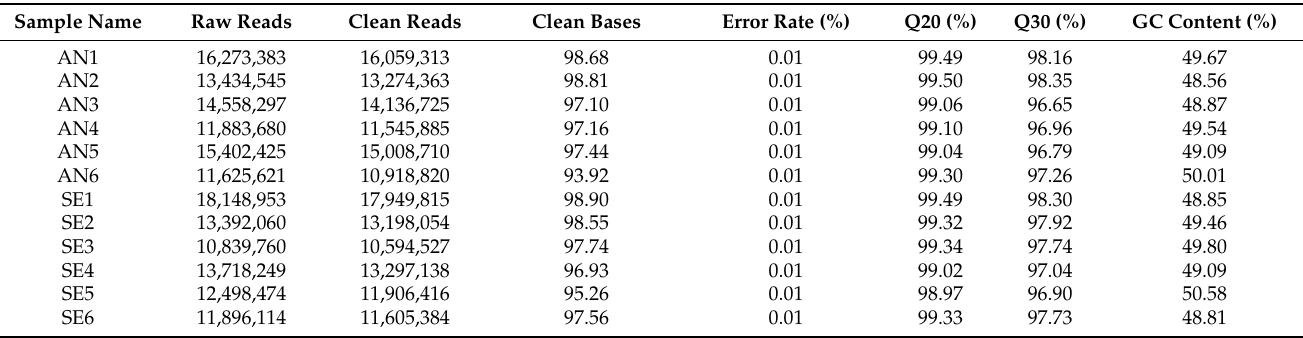
Table 2. Summary of the miRNA